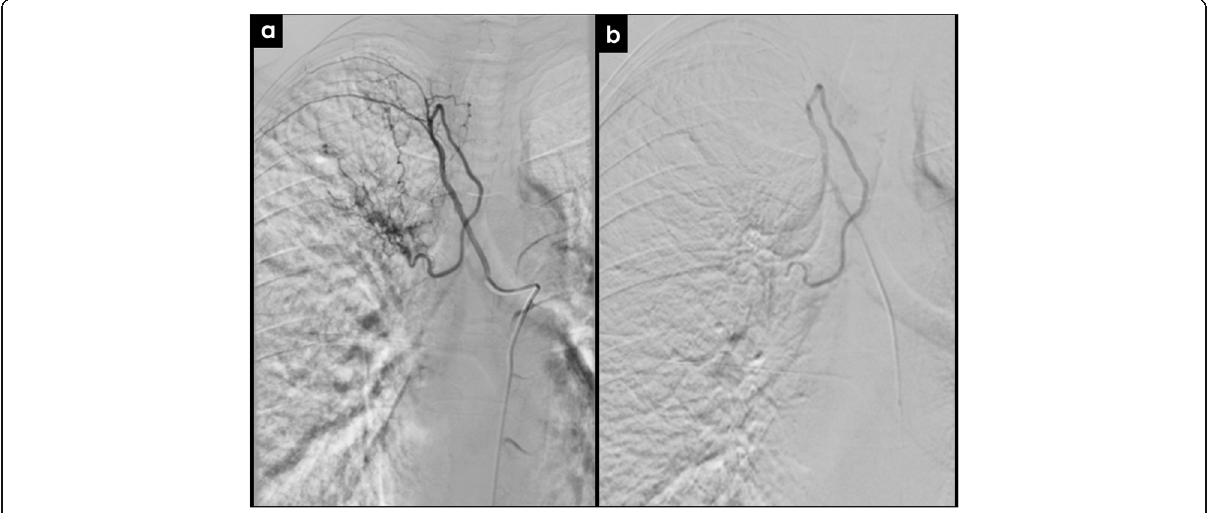
Fig. 13 Bronchial artery embolization. Selective catheter angiography before ( a ) and after ( b ) successful right bronchial artery embolization in a patient with hemoptysis in the context of chronic thromboembolic disease